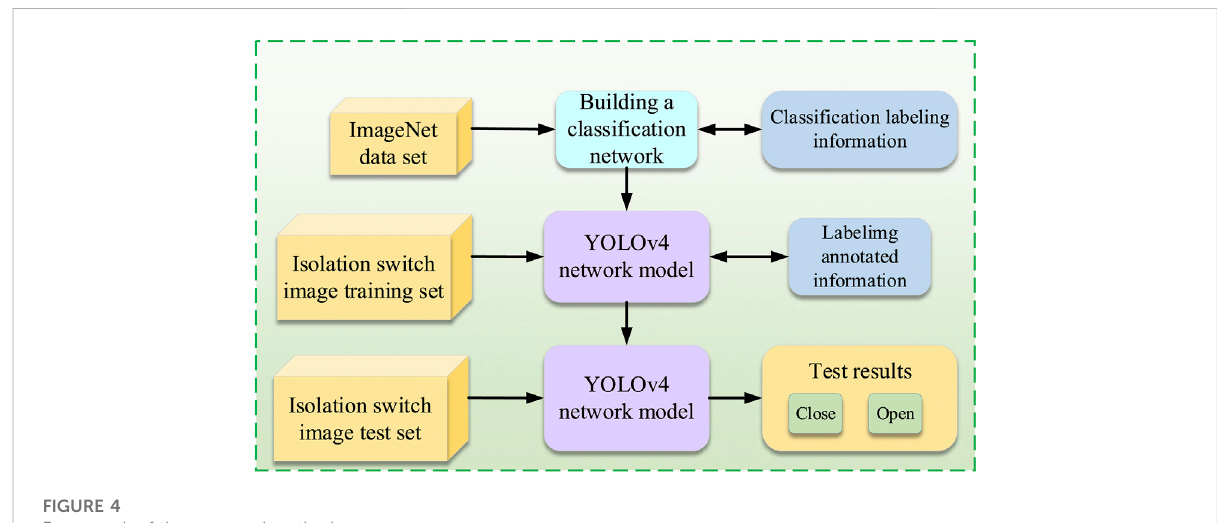
FIGURE 4 Framework of the proposed